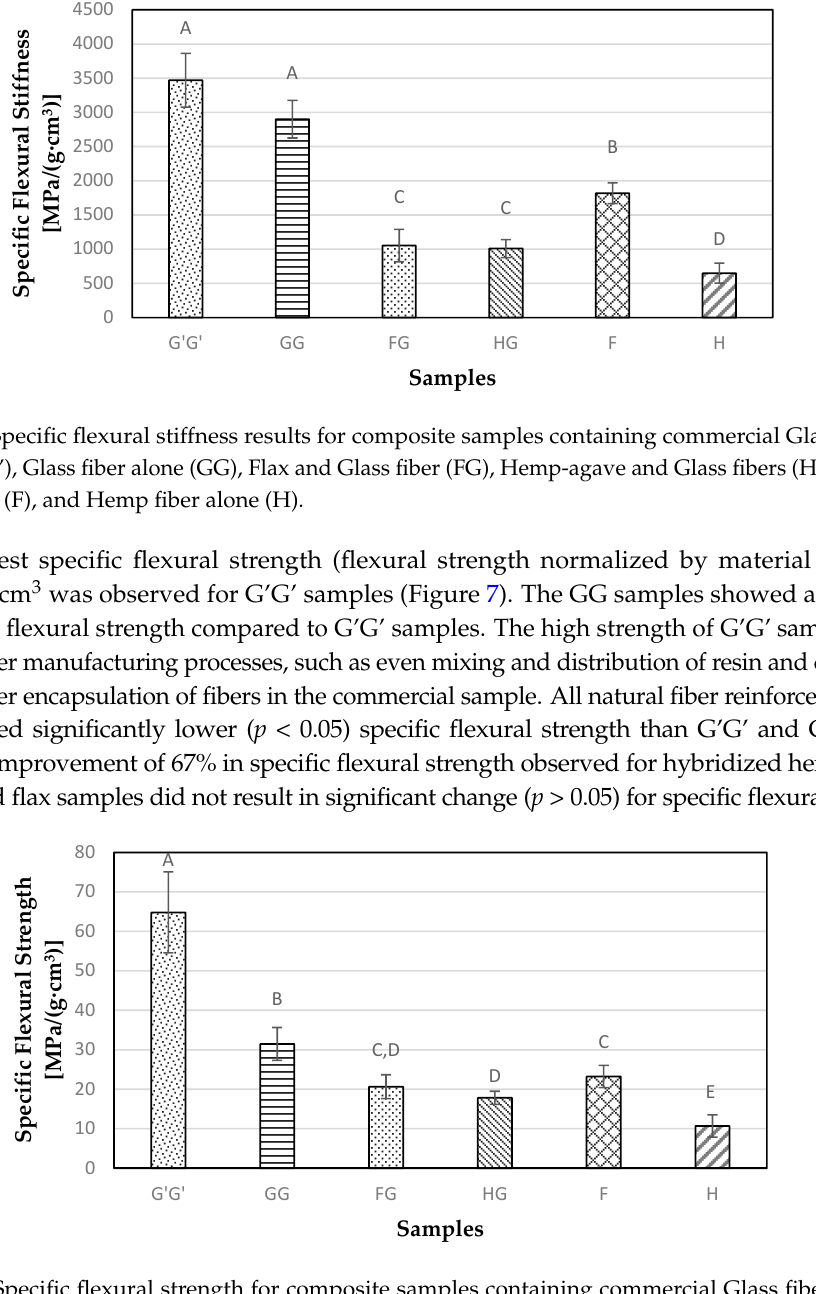
Figure 7. Specific flexural strength for composite samples containing commercial Glass fiber alone (G’G’), Glass fiber alone (GG), Flax and Glass fiber (FG), Hemp-agave and Glass fibers (HG), Flax fiber alone (F), and Hemp fiber alone (H).